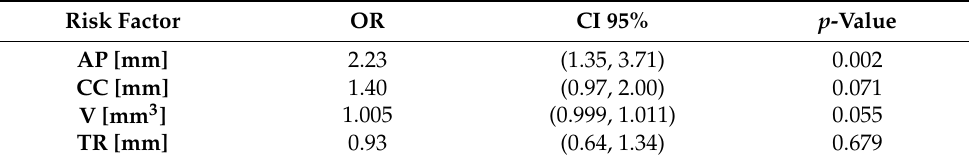
Table 2. Odds ratios (ORs) of the lack of a correct diagnosis of pituitary lesions in a conventional MRI examination (which includes common pre- and post-contrast sequences). Odds ratios (ORs) with 95% confidence intervals (CI 95%) and p -values. The table includes tree pituitary dimensions (antero-posterior [AP], cranio-caudal [CC], transverse [TR]) and gland volume [V], where AP is statistically significant ( p < 0.05), CC and V are on the border of statistical significance ( p < 0.1), and TR is statistically